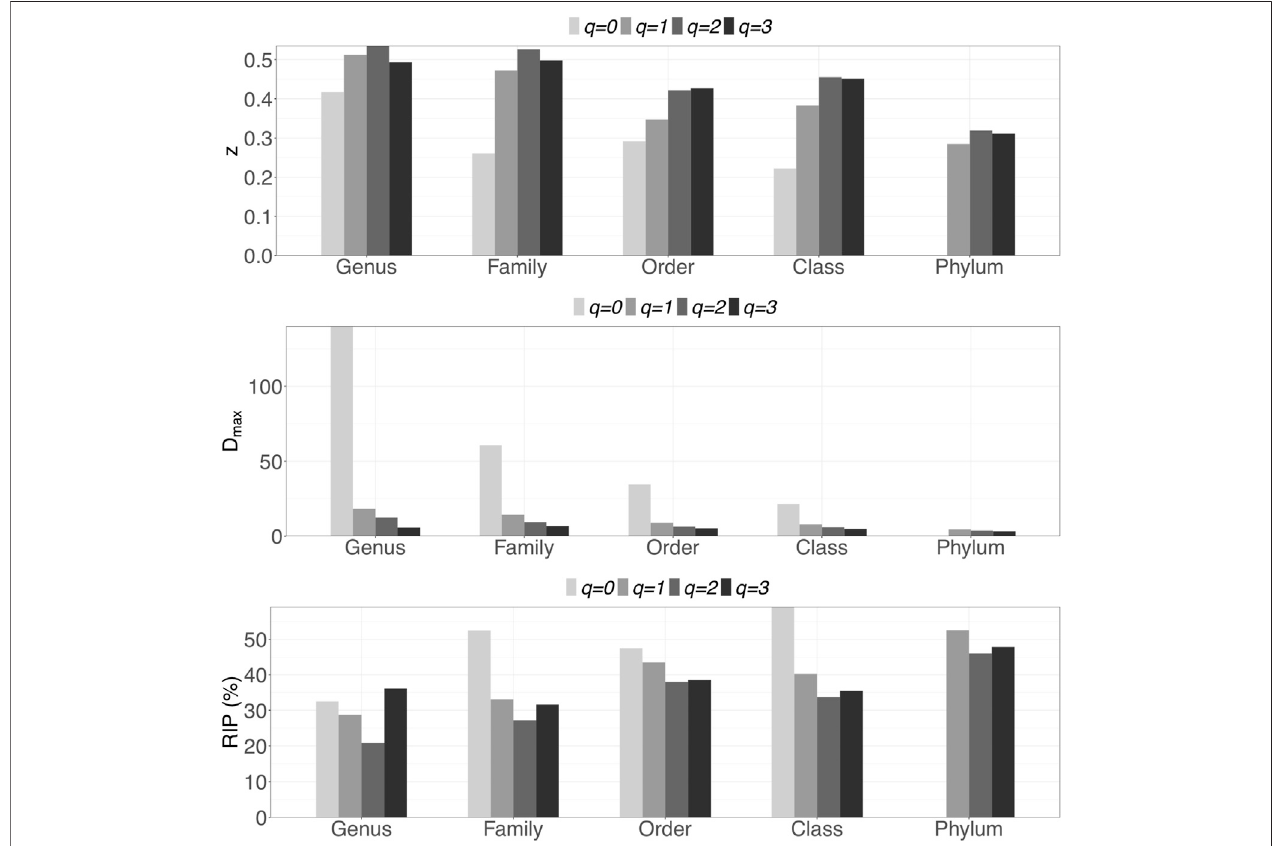
FIGURE2 | Graphs of three importantpro fi les from intra-individual DAR models for each ofthe fi ve taxon levels, including DAR pro fi les ( z-q patterns), MAD pro fi les ( D max - q patterns), and RIP pro fi les ( RIP - q patterns). Bar color indicates diversity